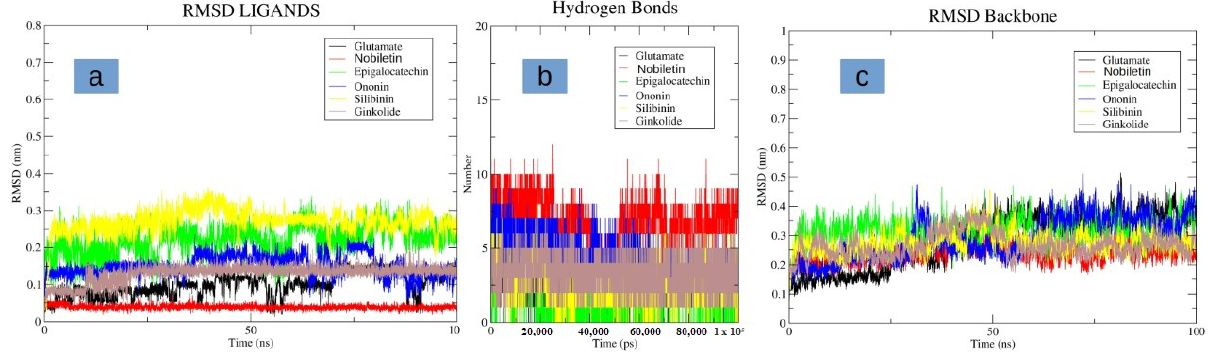
Figure 5. Displaying the molecular dynamics (MD) simulation. ( a ) RMS fluctuation of different and glutamate in the binding pocket of NMDA receptor ( b ) Hydrogen bond plots of the different ligands and glutamate with the NMDA receptor ( c ) RMSD of the protein backbone of the NMDA receptor when bound with different ligands and glutamate.